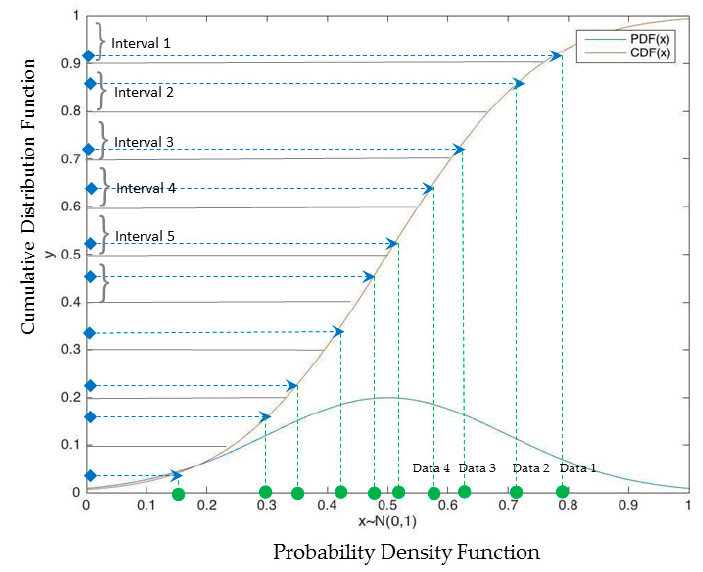
Figure 3. Illustration of the Latin Hypercube (LH) sampling process. The user decides the number of intervals to divide the distributions, and a sample is taken randomly from each interval.